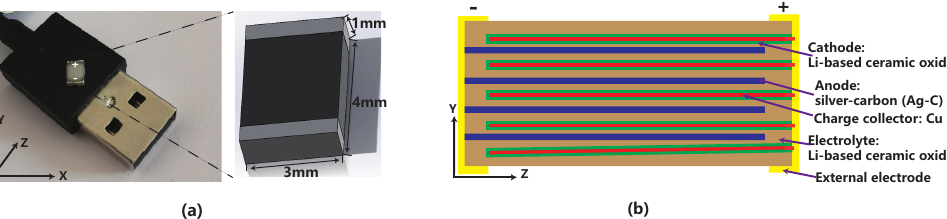
Figure 3. ( a ) Rechargeable solid-state battery (CeraCharge TM ) from TDK Corporation (www.tdk- electronics.tdk.com). ( b ) Z – Y cross-section view of the battery